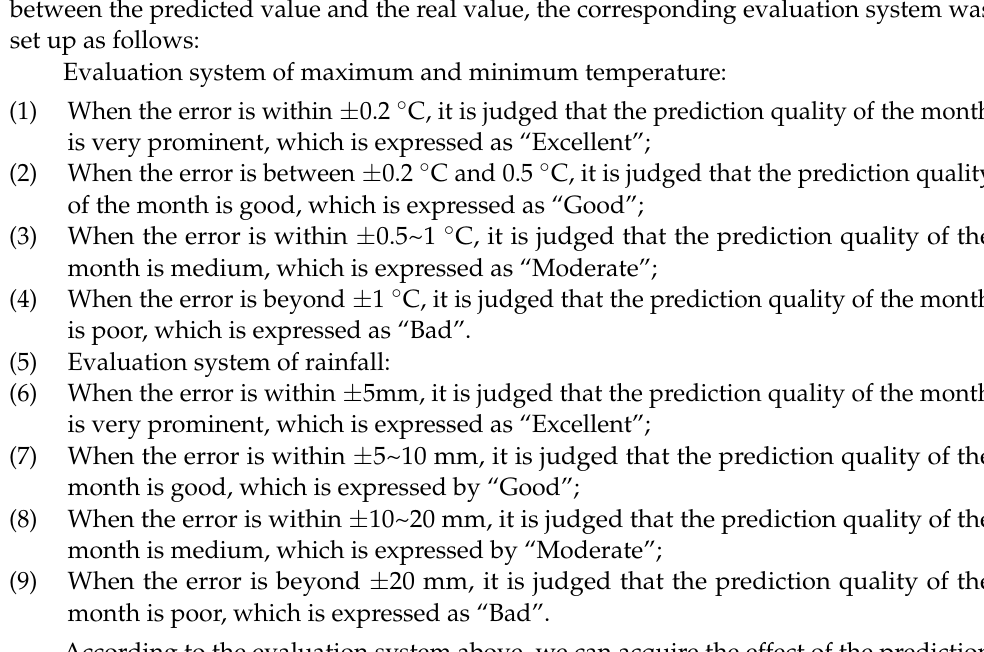
Figure 21. Predicting effect of the observed and predicted rainfall (unit: mm) using M6 – M9 mod- els.